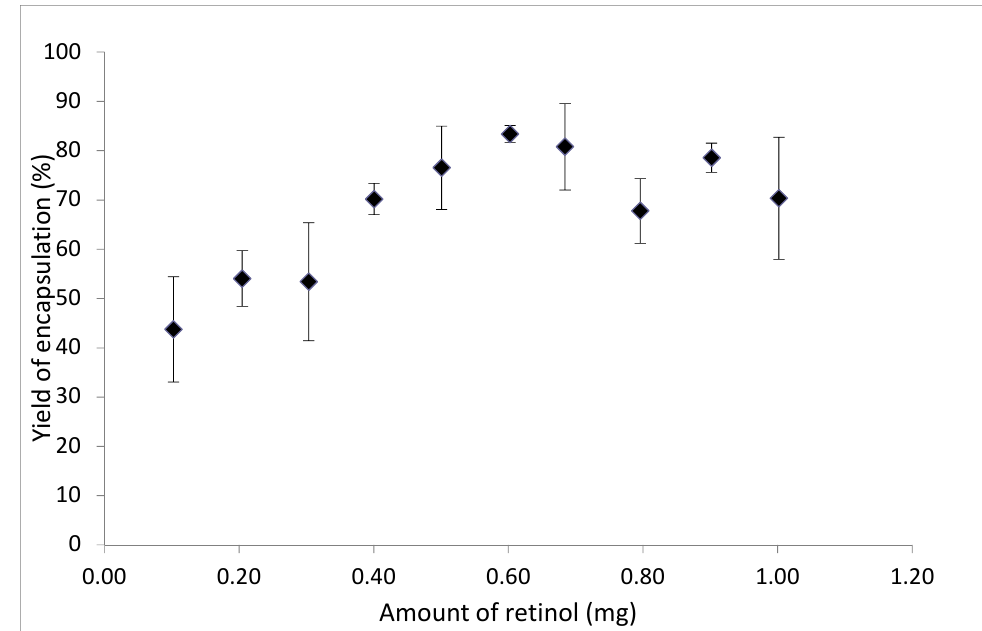
Figure 5. Encapsulation efficiency as a function of retinol amount.